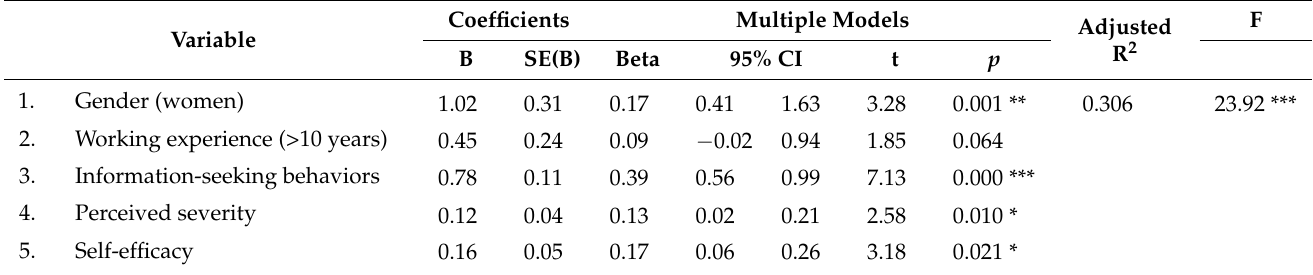
Table 4. Results of regression analysis of variables predicting flight attendants’ COVID-19-preventive